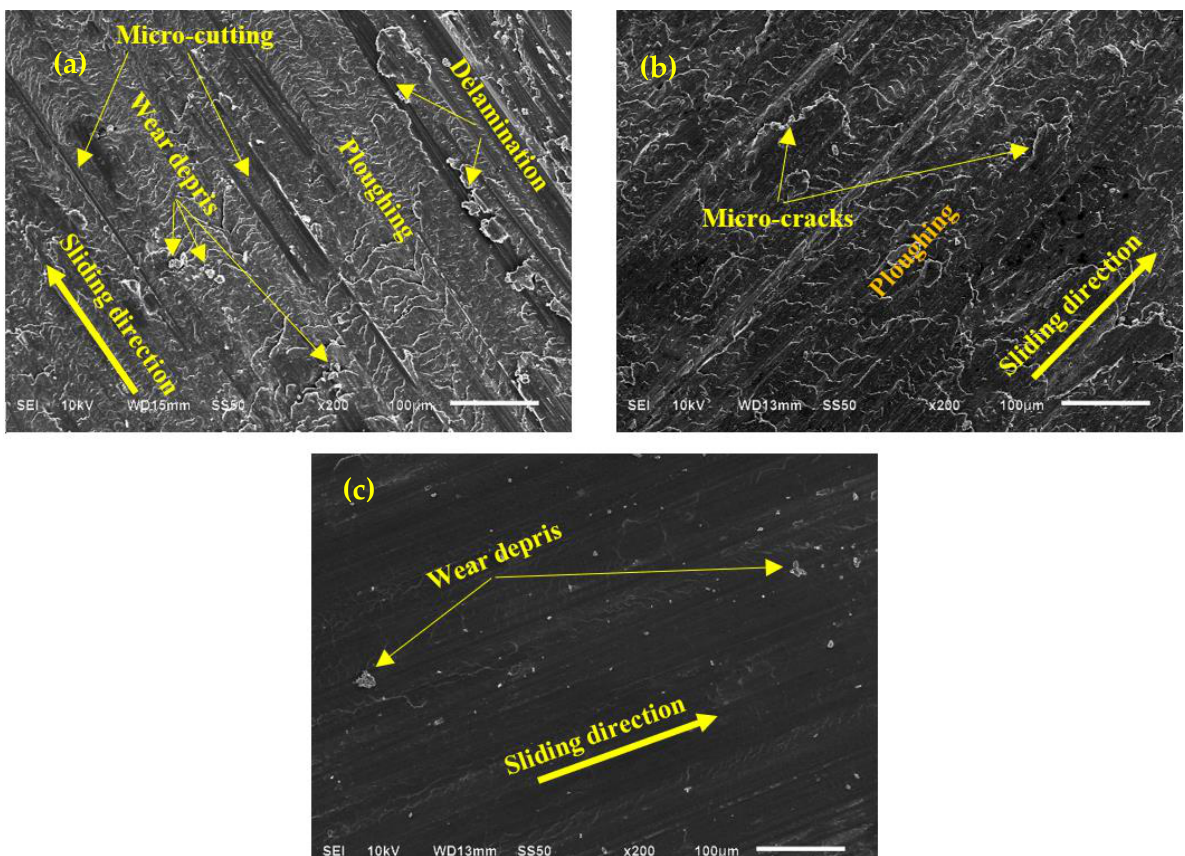
Figure 22. SEM photographs of Al/SiC composite worn surfaces ( a ) LHSBM, ( b ) LHLSBM, and ( c ) LHHSBM.